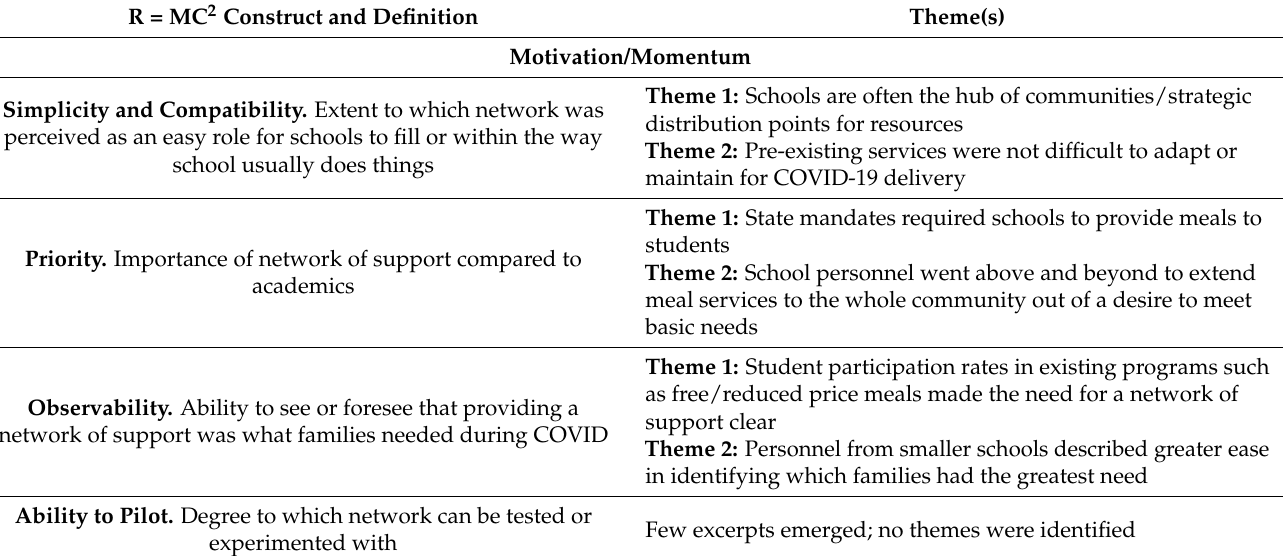
Table 2. Codebook definitions and themes for schools’ readiness to implement a wellness network of